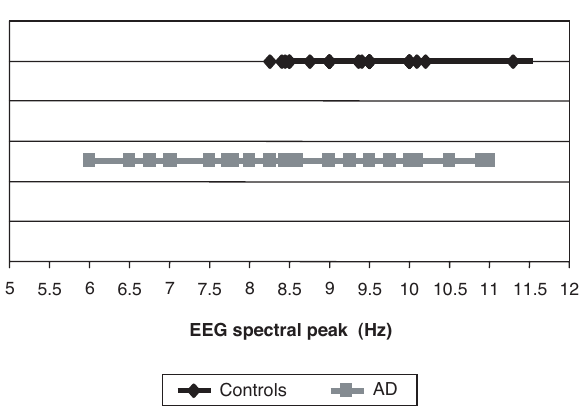
Graph 1. Dispersion of EEG spectral peak in this